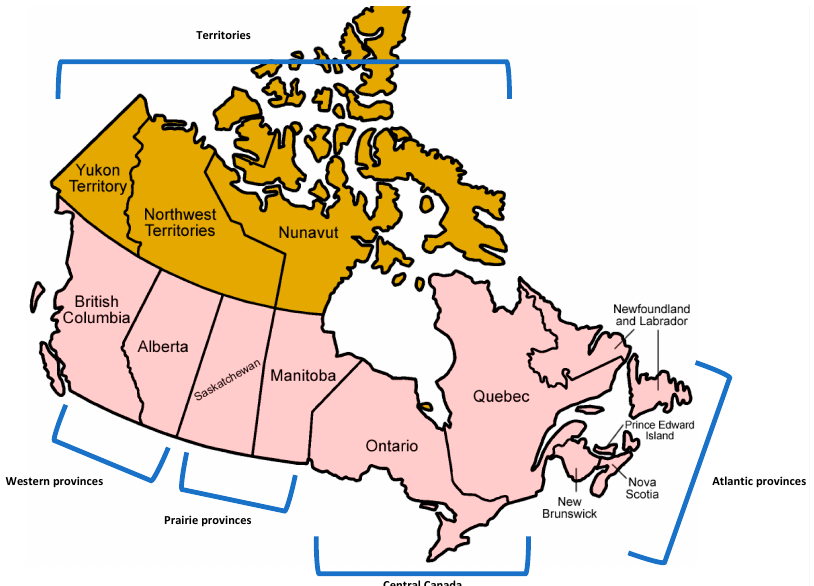
Figure A1. Regions of Canada.